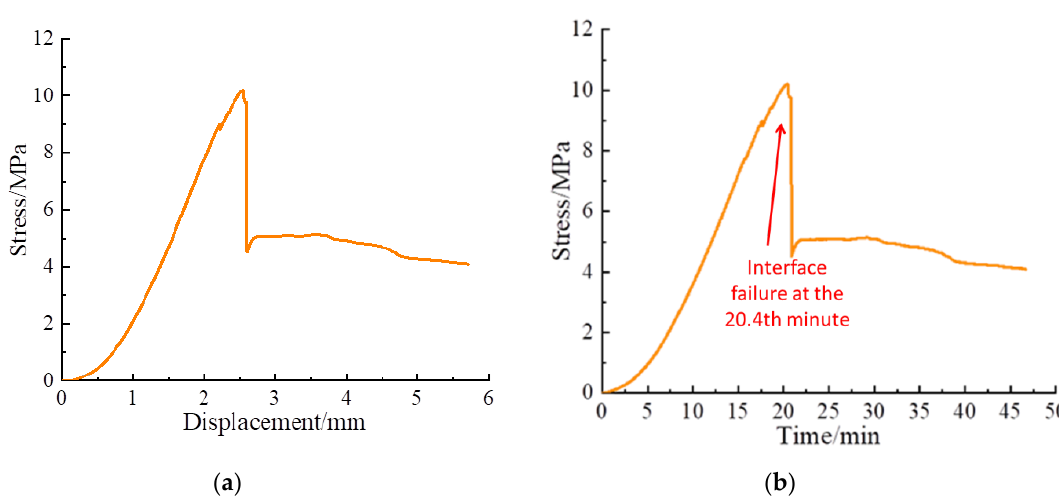
Figure 11. Shear test curve of Composite specimen Ⅲ : ( a ) Shear stress-displacement curve; ( b ) Shear stress-time curve .